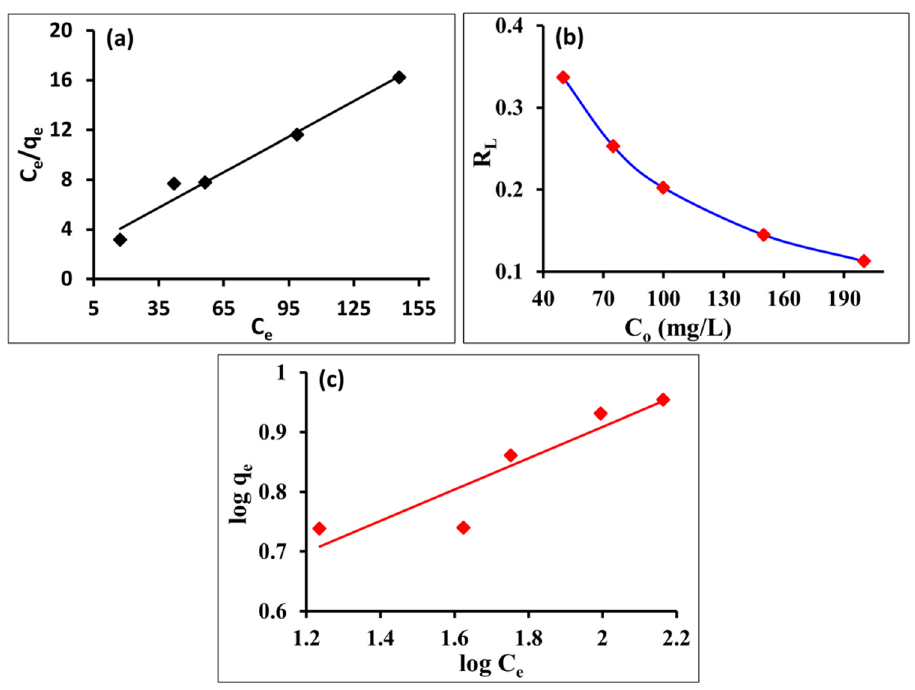
Figure 8. ( a ) Langmuir adsorption isotherm, ( b ) variation in R L values and ( c ) Freundlich adsorp- tion isotherm. Table 2. The calculated adsorption isotherm parameters for Co 2+ adsorption by ZrO 2 . Langmuir Freundlich T, K q